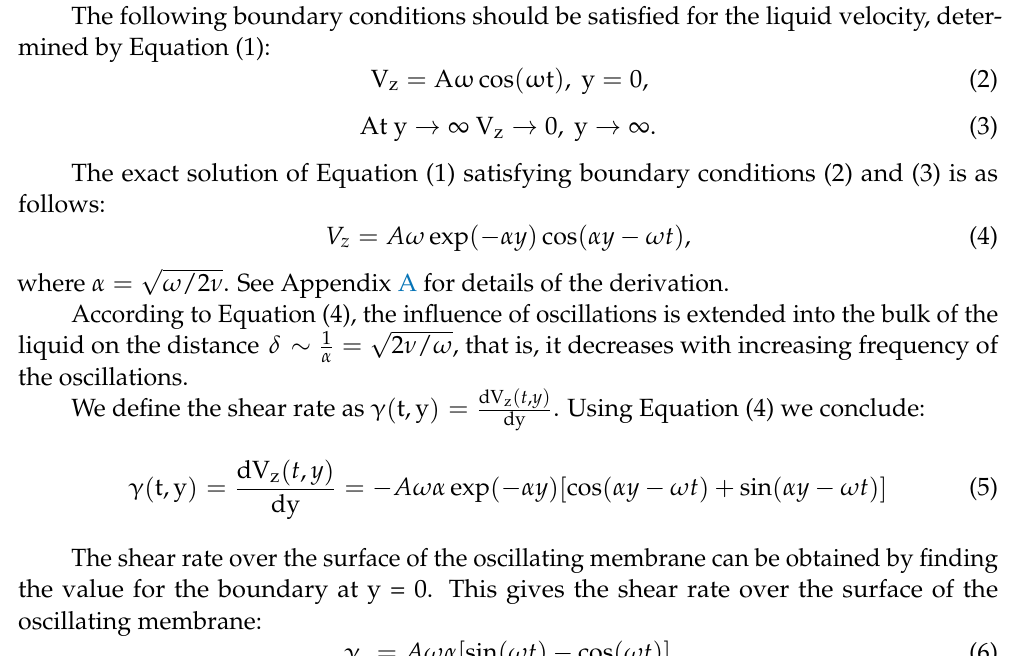
Figure 1. Velocity distribution of the fluid and motion of foulants in the vicinity of the submerged oscillating membrane.